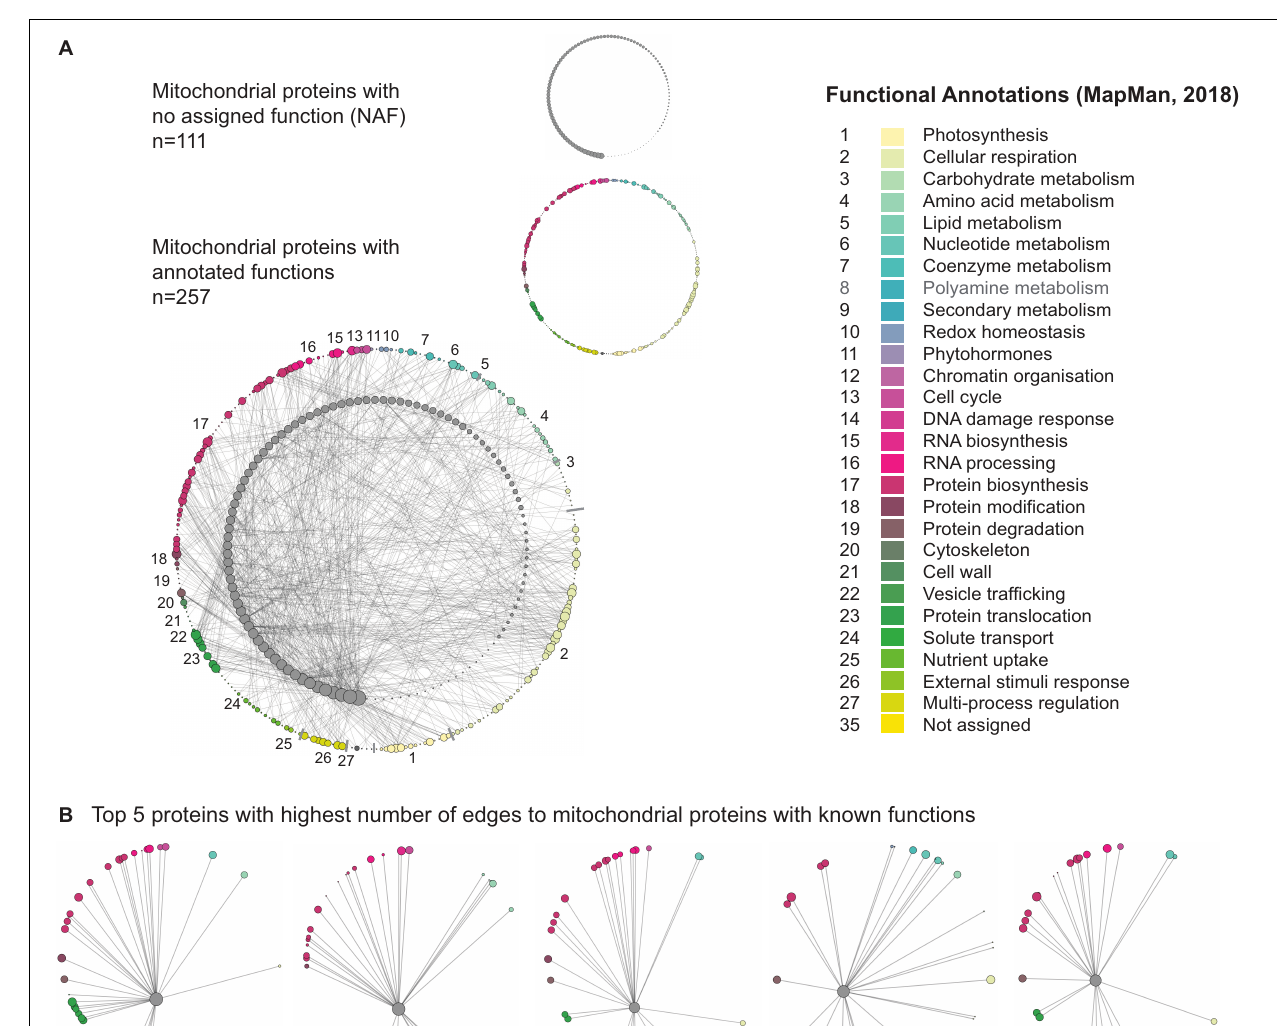
Frontiers in Plant Science |